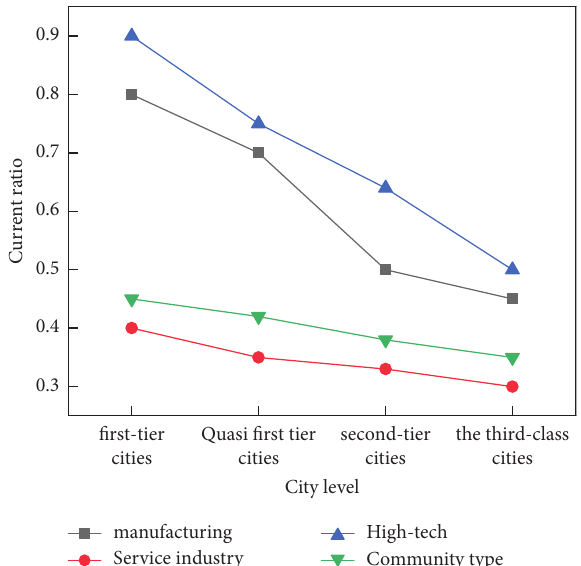
Figure 7: Current ratio of industries in different cities.